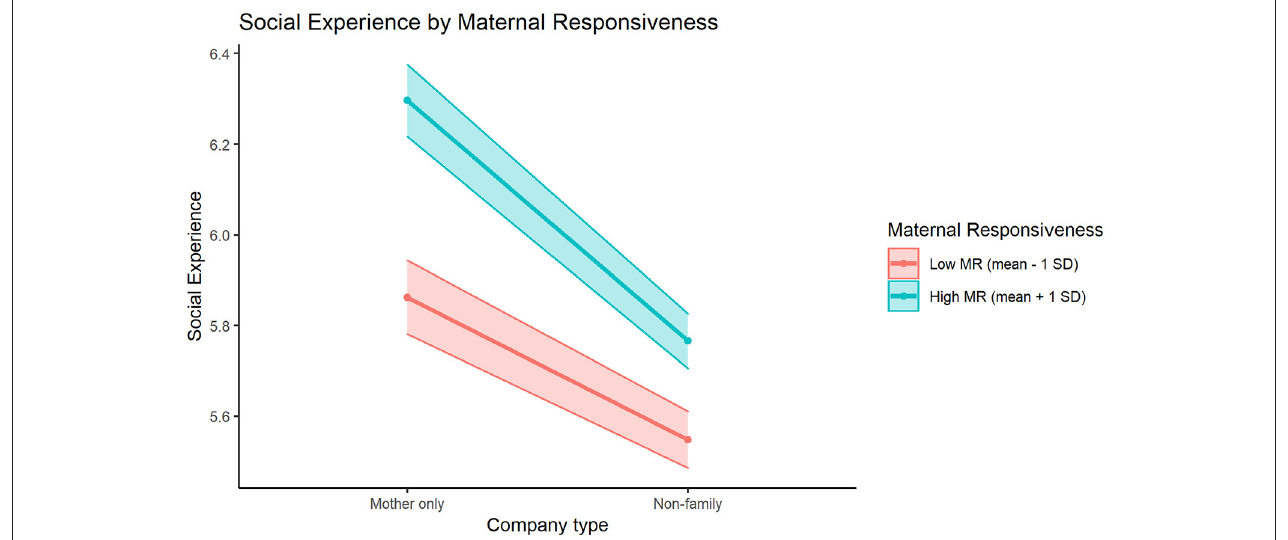
FIGURE 1 | The significant interaction effect between MR (Maternal Responsiveness) and maternal vs. non-family company in the prediction of mean social experience, for participants ± 1 standard deviation of the Maternal Responsiveness mean (5.27).